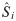
The S^i’s obtained from the SVM model with 18 metabolites arranged in decreasing order of their magnitudes.